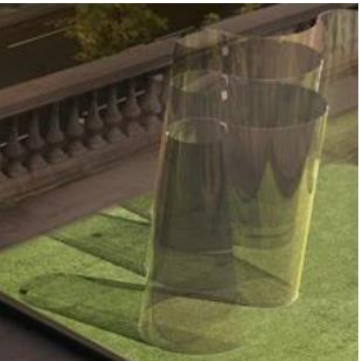
Fig. 2 Flowing glass sculpture (Lambert, O’Callaghan